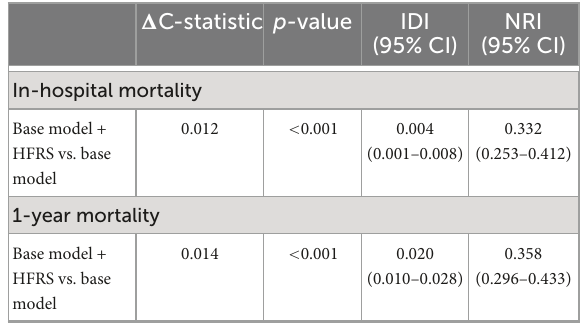
TABLE 3 Incremental value of HFRS for in-hospital and 1-year mortality.